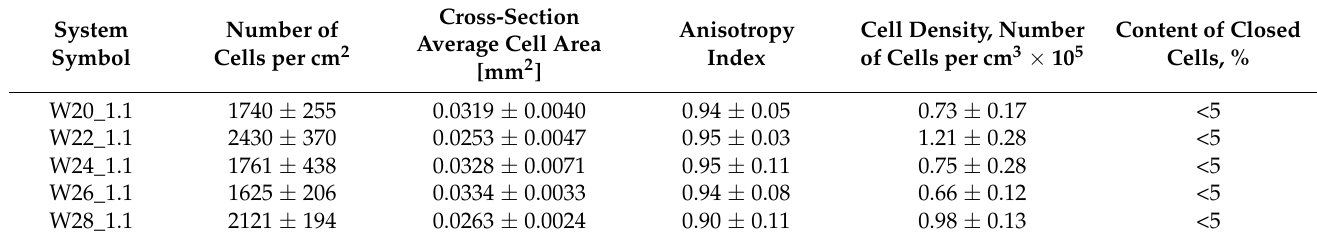
Table 3. Characteristics of the cell structure of PU foams.